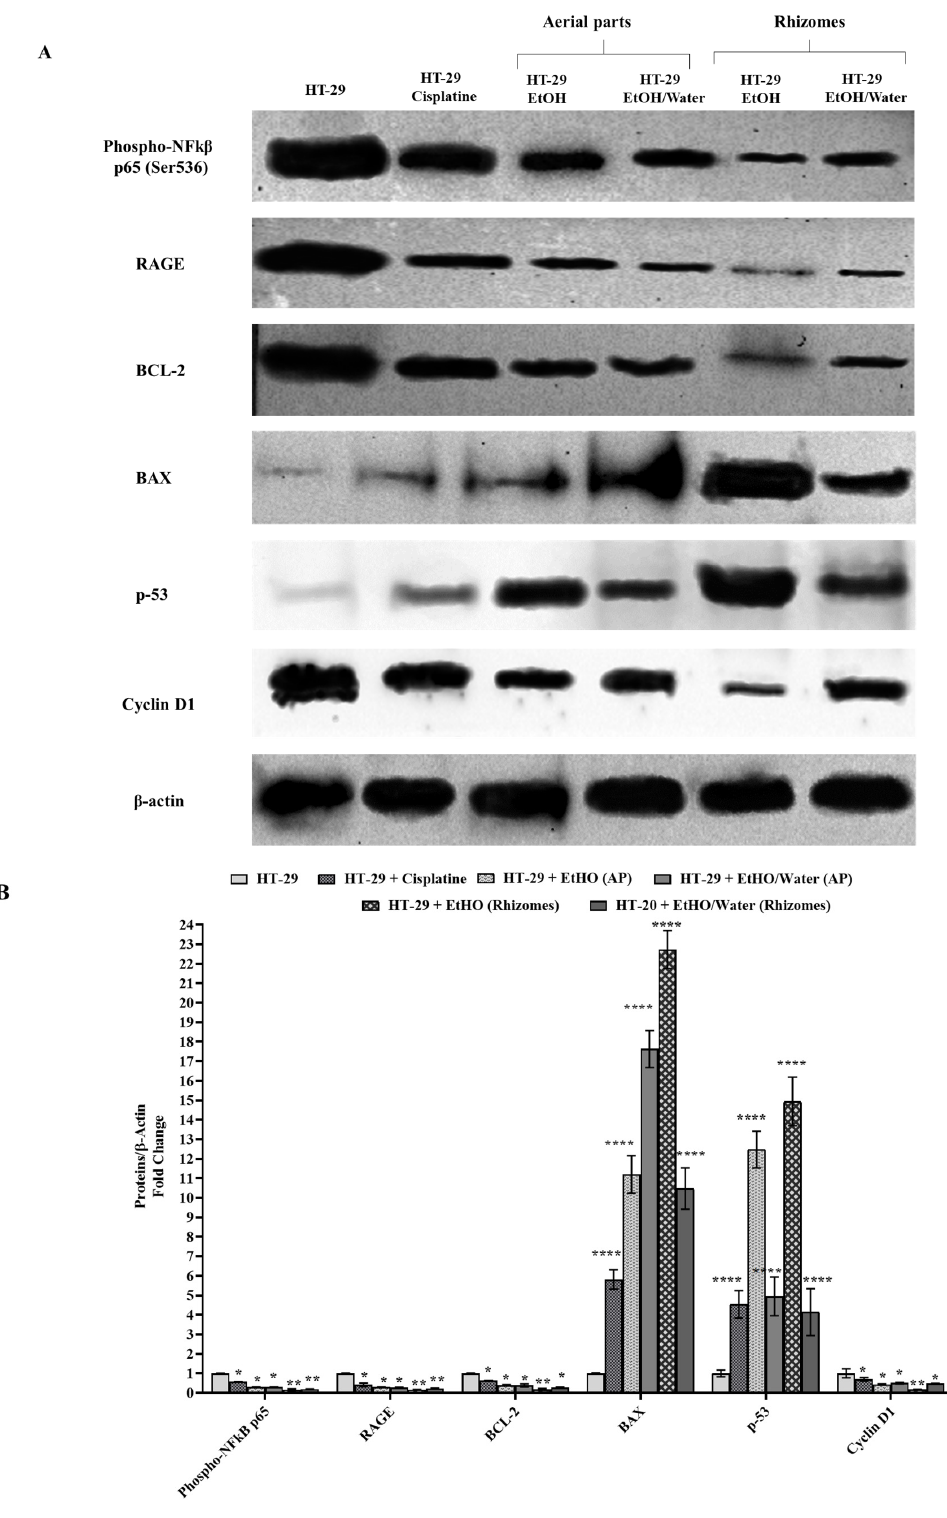
Figure 6. Determination of the effect of 50 µ g/mL EtOH and EtOH/water extracts obtained from different parts of Primula auriculata on protein synthesis by Western blot. The band densities of phospho-NF- K β , RAGE, BCL-2, BAX, p-53, and cyclin D1 proteins on the nitrocellulose membrane were visualized by ChemiDOC in ( A ). β -actin was used as a loading control and 1-fold was assumed for comparison. In ( B ), statistical analysis was performed with GraphPad Prism 8, and * was used for p ≤ 0.05, ** was used for p ≤ 0.01, and **** was used for p ≤